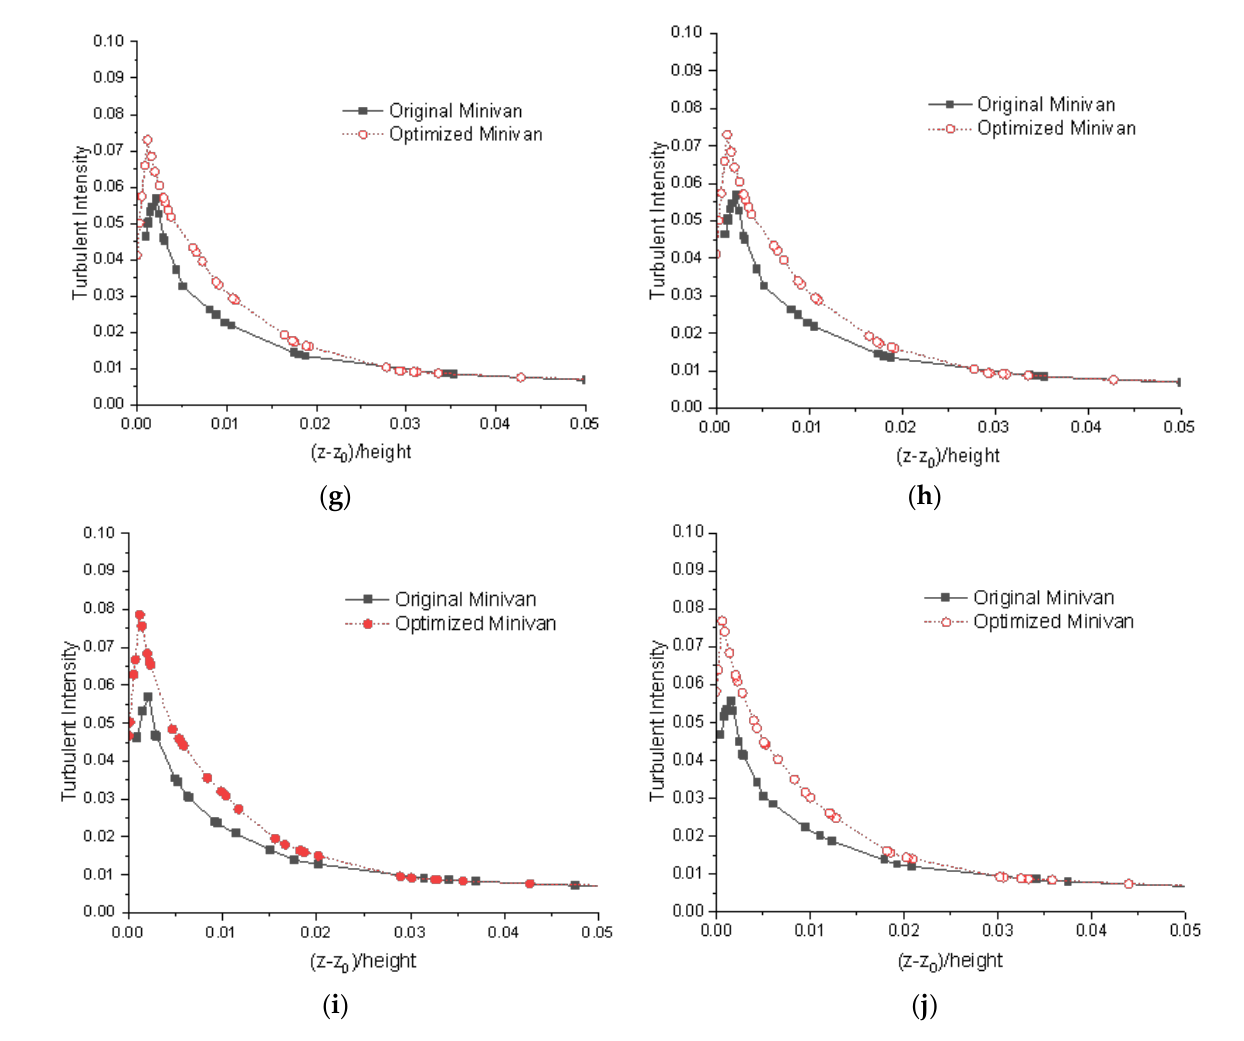
Figure 12. Profiles of turbulent intensity: ( a ) x = 0.5 L, ( b ) x = 1.5 L, ( c ) x = 2.5 L, ( d ) x = 3.5 L, ( e ) x = 4.5 L, ( f ) x = 5.5 L, ( g ) x = 6.5 L, ( h ) x = 7.5 L, ( i ) x = 7.5 L, ( j ) x = 8.5 L .